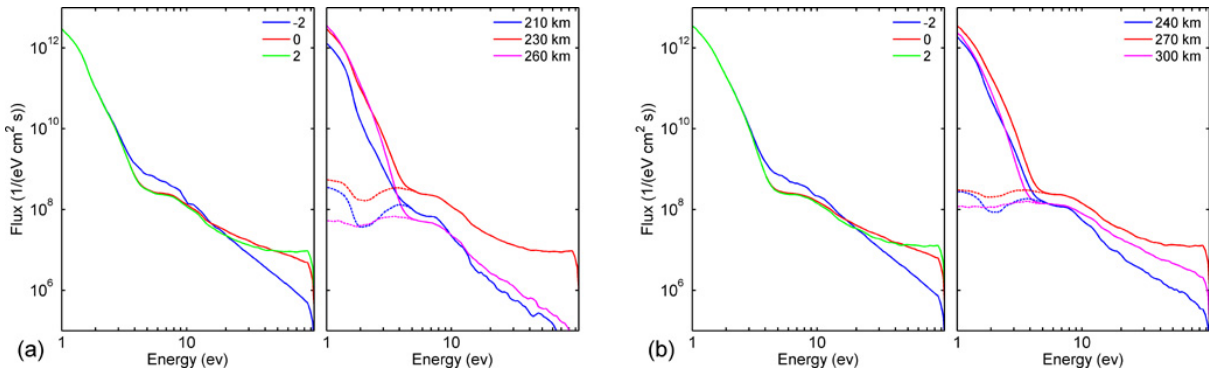
Fig. 9. (a) Energy dependence of the electron differential flux for the heating pulse at 18:12UT. Left: The differential electron fluxes for the power-law acceleration source with the different exponents at the electron acceleration altitude (230km). Right: The electron differential fluxes at various altitudes calculated for the acceleration source with the exponents 2. The dashed lines show the differential flux formed solely by the accelerated electrons; (b) same as panel (a) for the heating pulse at 18:54UT.